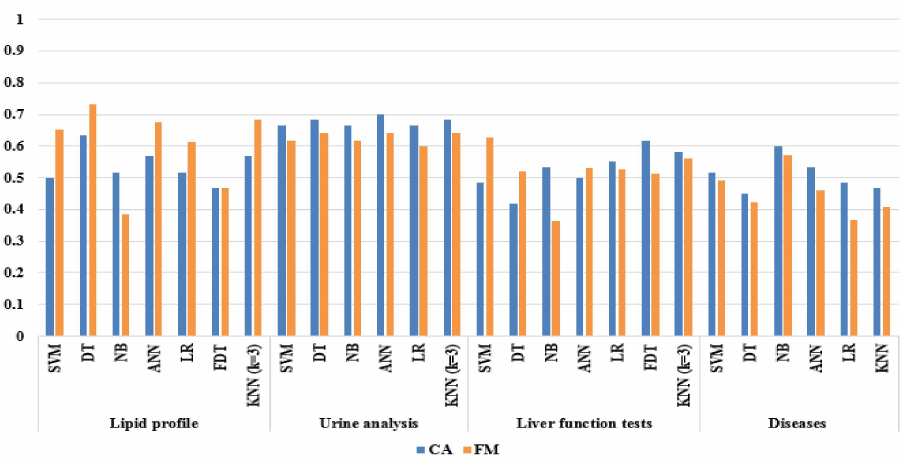
Figure 5. A comparison between CA and FM for base classifiers using CFS (part